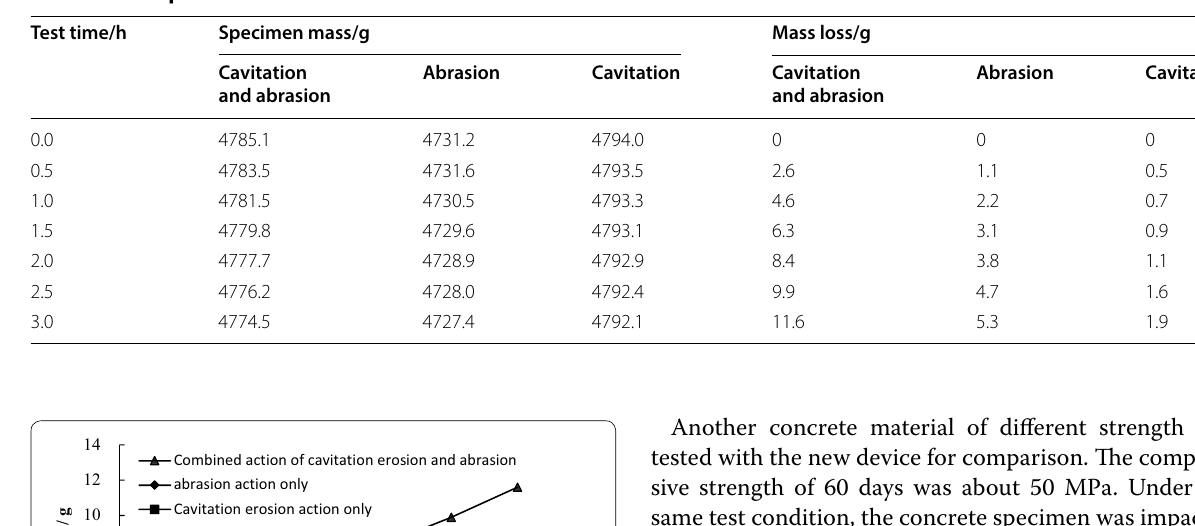
Table 2 Wear parameters.